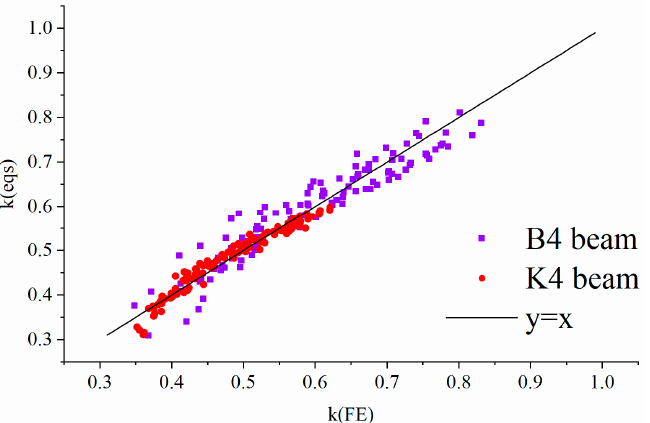
Figure 11. Comparison of the value of k calculated by Equations (5) and (6) and obtained from FE